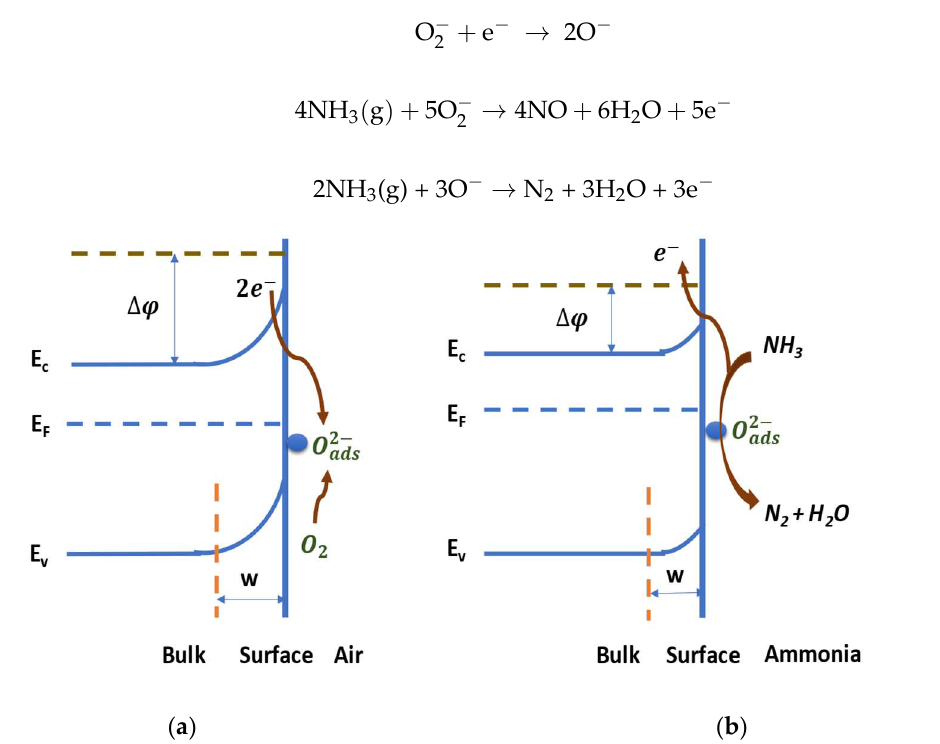
Figure 8. Mechanism of sensing in the presence of ( a ) Air ( b ) Ammonia for Zn:WO 3 film.